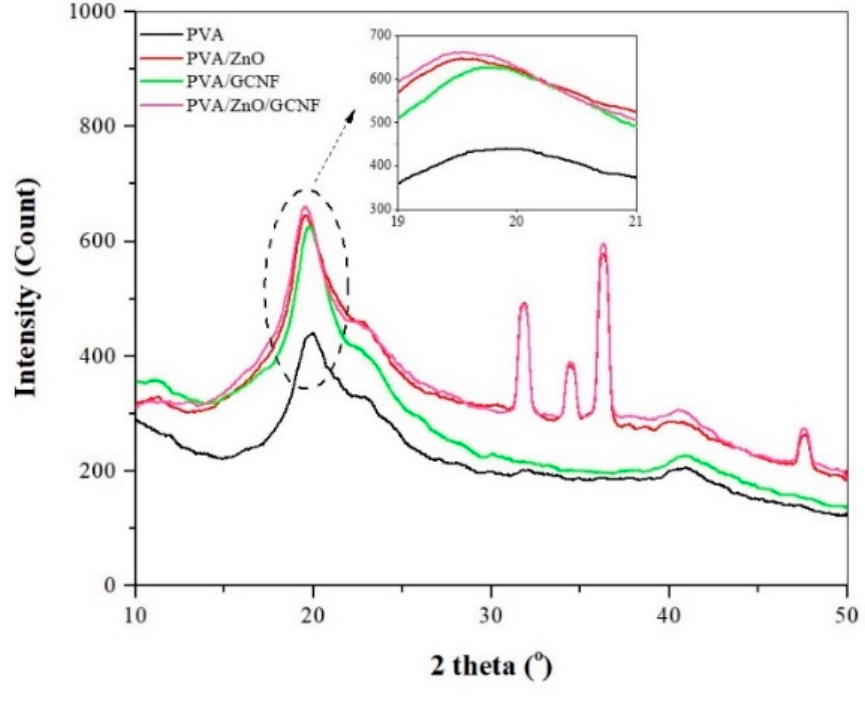
Figure 3. XRD pattern for samples. Table 2. d-spacing, FWHM, and the peak position at 2 θ around 19.6 ◦ of films recorded from X-ray diffraction testing from Figure 3, and T m from Figure